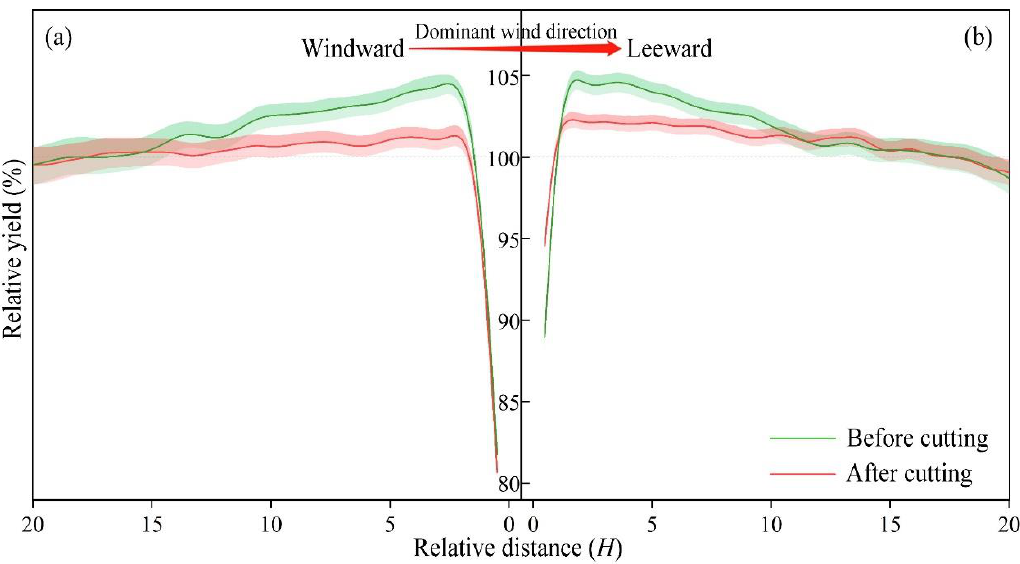
Figure 4. The relative yield profiles on the windward ( a ) and leeward ( b ) sides. The shaded parts represent the 95% confidence interval.